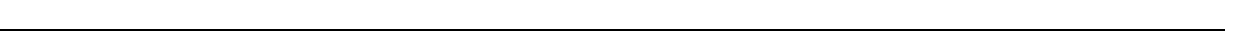
Fig. 3 Presynaptic excitability at synapses onto axotomized neurons. a A representative neuron retrogradely labeled with a modi fi ed eGFP rabies virus via the axonal compartment. Enlarged region shows FM puncta colocalized with eGFP dendrites and spines ( arrows ). ImageJ ‘ fi re ’ color look-up-table for FM puncta shown in the next panel. Scale bar , 20 µ m. b Representative images show FM puncta colocalized with eGFP dendrites (outlined in white dashed lines ) before and after fi eld stimulation in uninjured control, and 24 h and 48 h post-axotomy. Arrows highlight destaining at spines. Scale bars , 10 µ m. c FM unloading curves of colocalized puncta 24 h post-axotomy (control, n = 185 puncta; axotomy, n = 256 puncta) and 48 h post-axotomy (control, n = 232 puncta; axotomy, n = 322 puncta). Two-way ANOVA, Bonferroni post hoc test. Inset shows FM decay time constant ( τ ) for puncta with τ < 360 s (24 h control, n = 151; 24 h axotomy, n = 201; 48 h control, n = 211; 48 h axotomy, n = 304). b , c Unpaired two-tailed t -test. Each condition includes 5 –